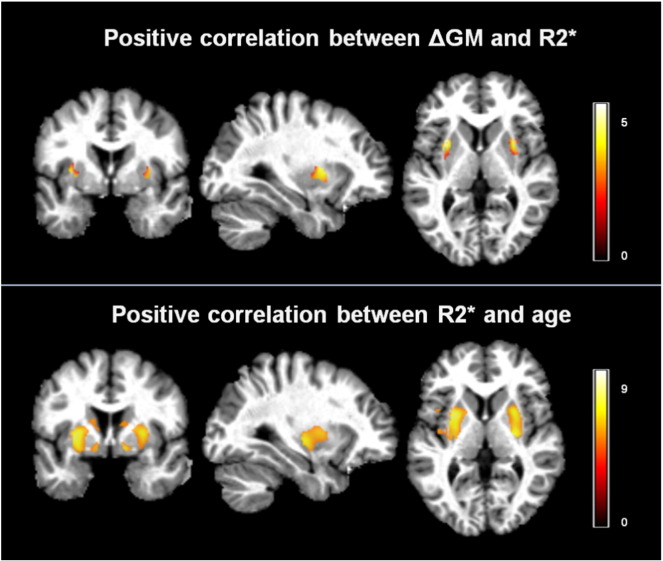
Top panel: t-values of voxel-based regressors correlating R2* with higher age-related gray matter (GM) volume loss estimated with conventional tissue probability maps (TPM). Bottom panel: t-values for the positive linear correlation between R2* and age in GM voxels.